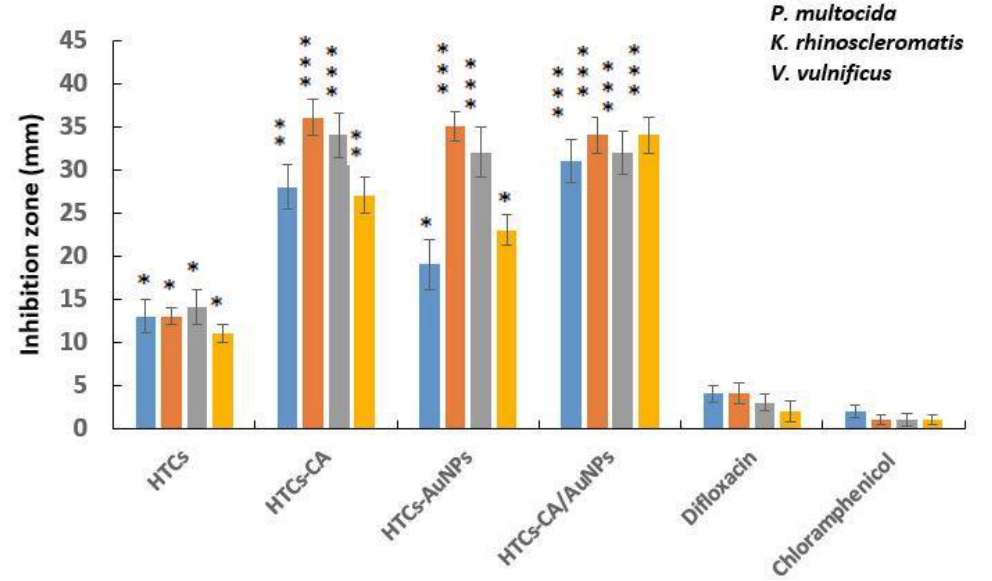
Figure 2. The antibacterial activity of the electrospun mats of HTCs, HTCs-capsaicin, HTCs-AuNPs and HTCs-capsaicin / AuNPs against P. multocida, K. rhinoscleromatis, S. pyogenes, and V. vulnificus . (Data are presented as mean ± S.D., (* P < 0.05; ** P < 0.01; *** P < 0.001); n = 3). (CA refers to capsaicin).